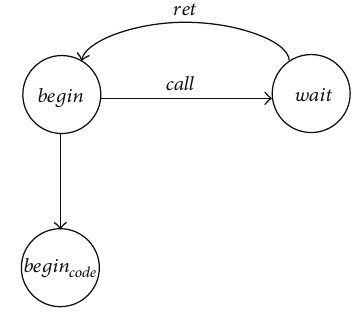
Figure 10: Function call instruction translation